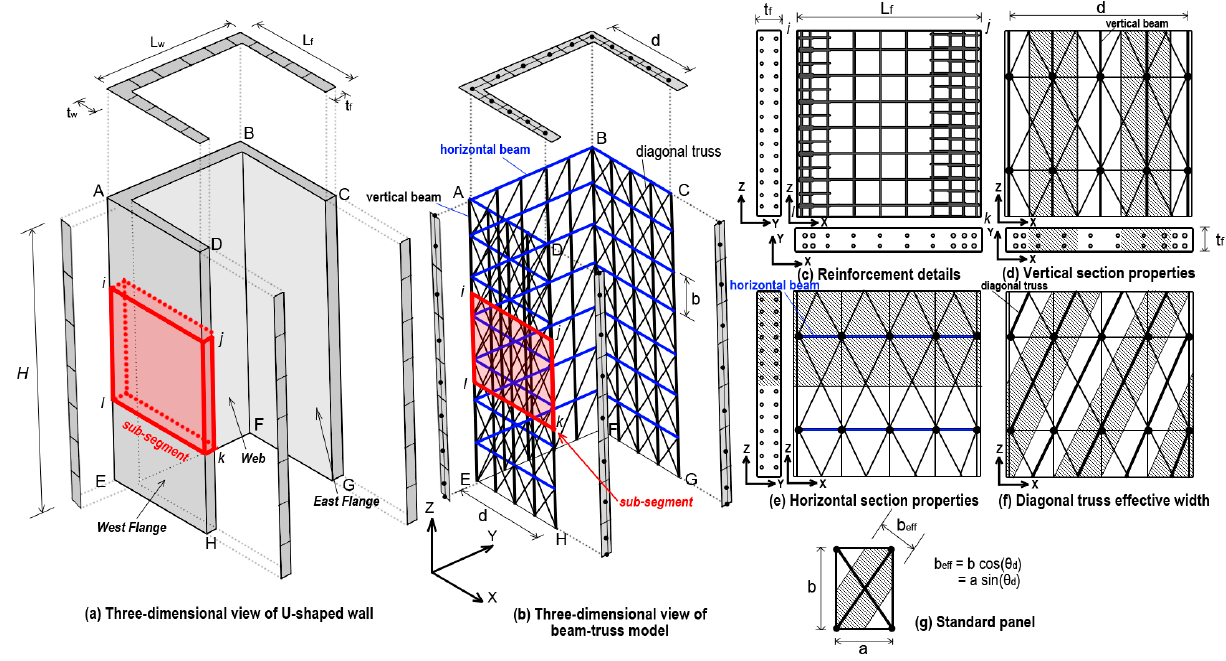
Figure 3. Schematic illustration of the beam-truss model approach for a U-shaped wall (adapted from Lu et al. [23] and modified for the wall section of interest for this work).